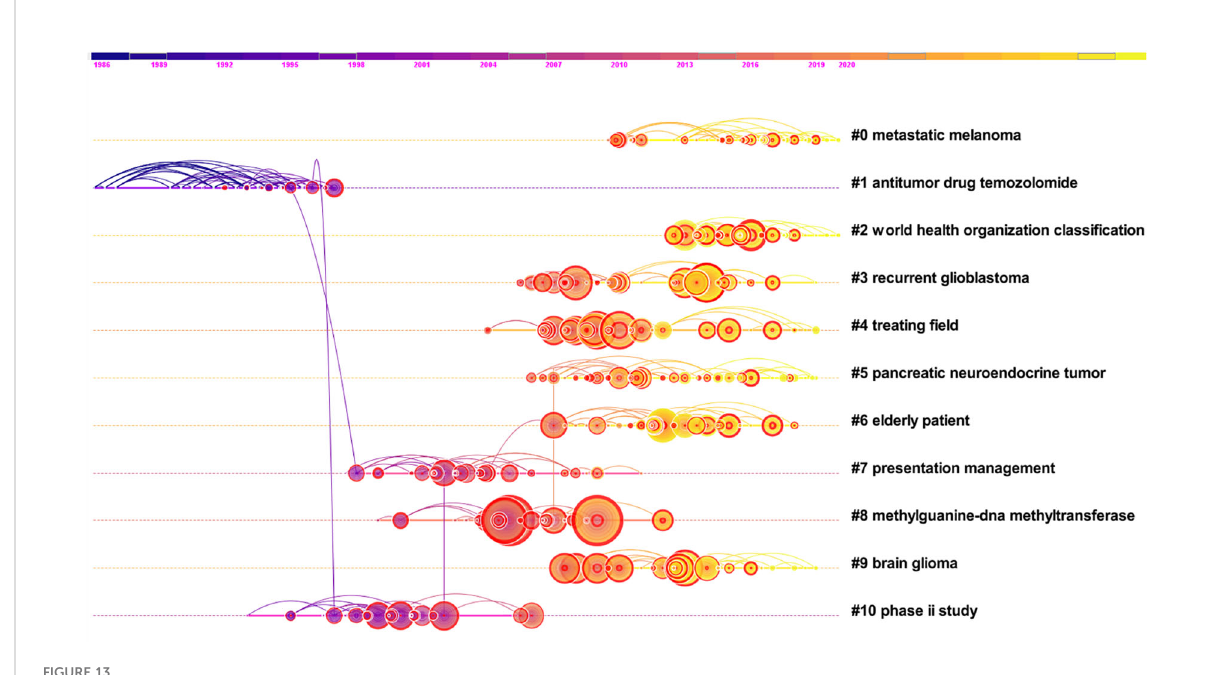
FIGURE 13 Visualized timeline of co-citation clusters in the TMZ research area.